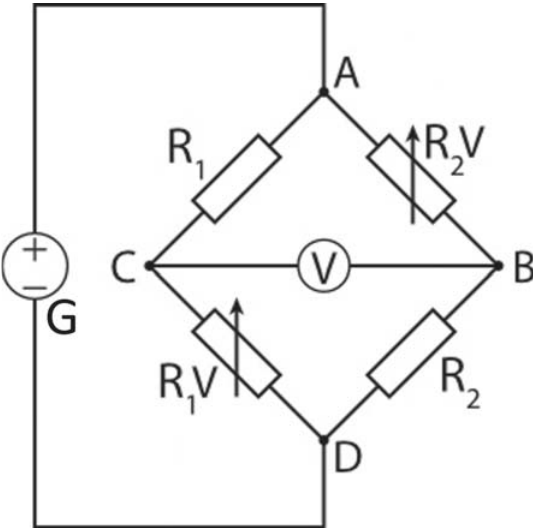
Fig. 2 - Esquema básico da ponte de Wheatstone, utilizada nos transdutores de pressão mais simples. A, B, C, D = pontos de intersecção do circuito; G = gerador; V = voltímetro; R1, R2 = resistências fixas; R V, R V = resistências 1 2